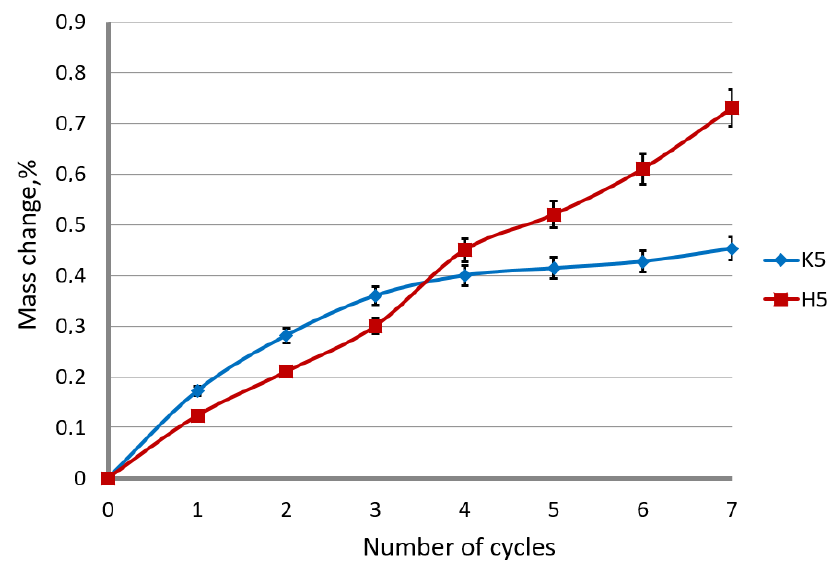
Figure 8. The mass change of the galvanized wires drawn with the conventional (K5) and hydrodynamic (H5) method with a speed of 5 m/s as a function of the number of exposure cycles in the sulfur dioxide chamber.